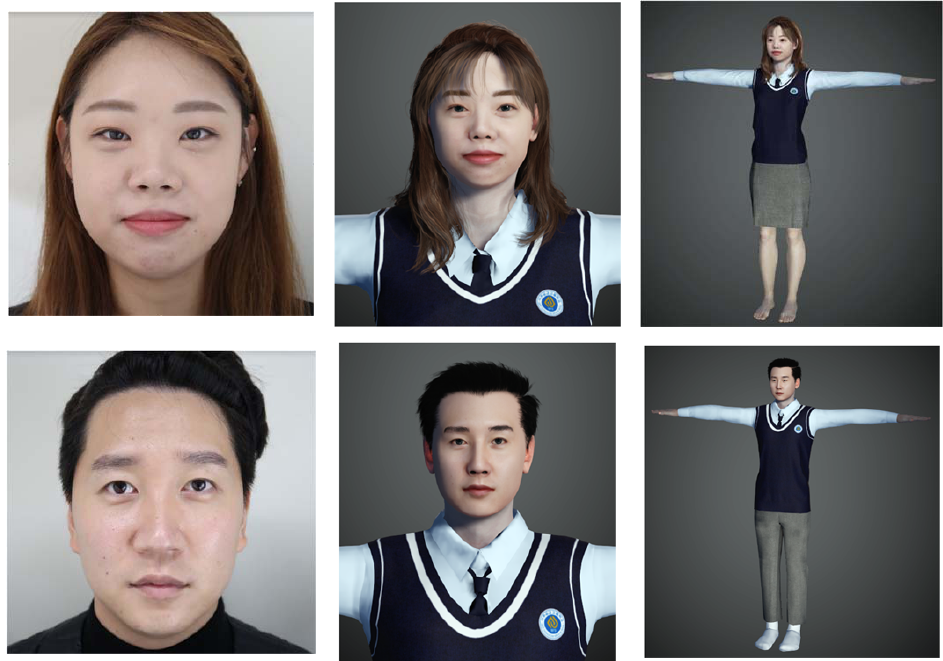
Figure 5. Examples of created female ( top ) and male ( bottom ) avatars: facial photographs ( left ); avatar faces based on the photographs ( middle ); full bodies of the avatars ( right ).